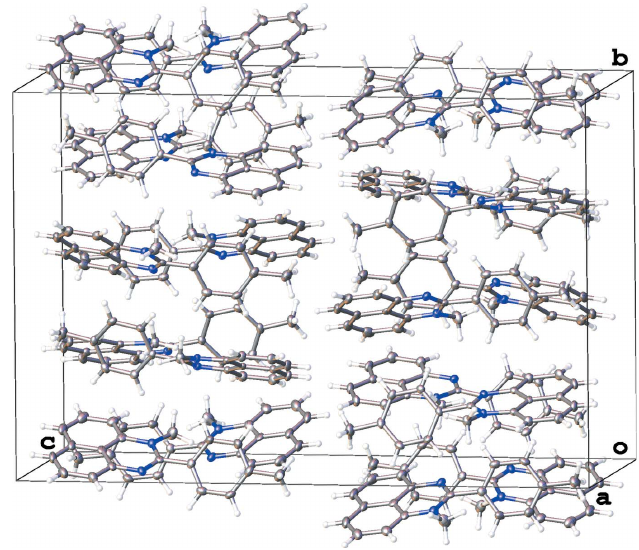
Figure 4 Fragment of the crystal packing of 1-methyl-2-( p -tolyl)-perimidine ( 2 ), with displacement ellipsoids drawn at the 50% probability level. Hydrogen atoms of the minor parts of the disordered methyl groups are omitted for